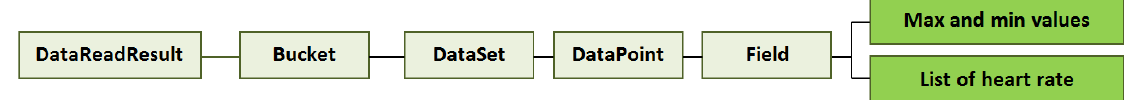
Figure 6. Hierarchy of History Application Programming Intreface (API) Class.